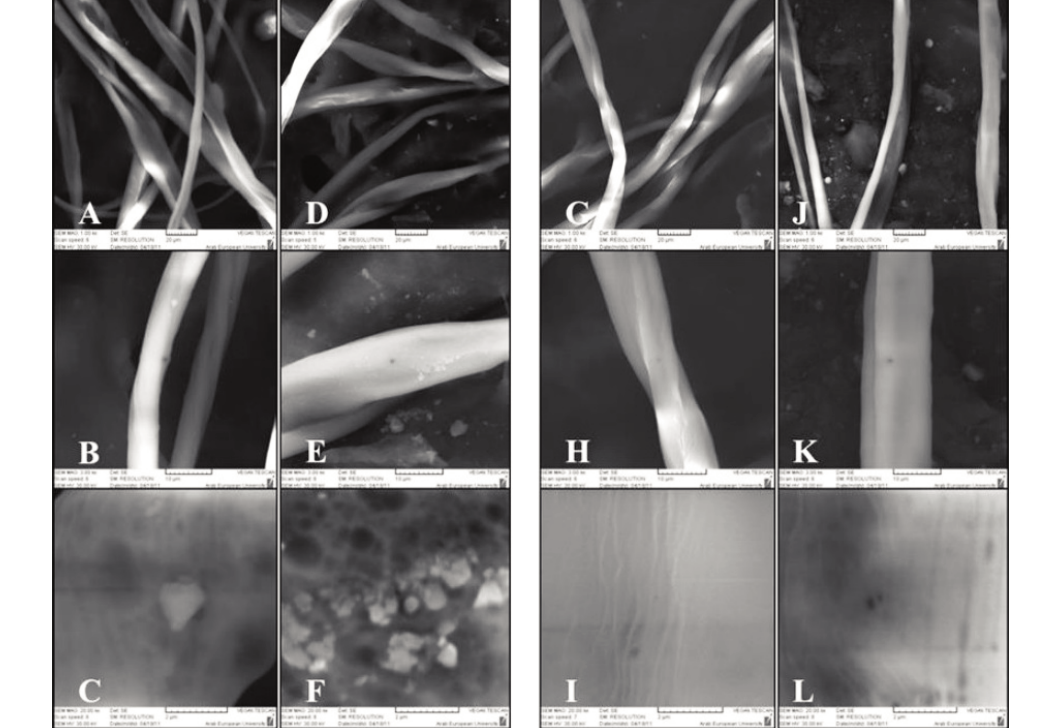
Fig. 7 - SEM images of cotton fibers. A, B and C. fibers of control ‘Aleppo 118’ under 1.00, 3.00 and 20.00 kx magnifications. D, E and F. fibers of treated ‘Aleppo 118’ under 1.00, 3.00 and 20.00 kx magnifications. G, H and I. fibers of control ‘Deir Al Zour 22’ under 1.00, 3.00 and 20.00 kx magnifications. J, K and L. fibers of treated ‘Deir Al Zour 22’ under 1.00, 3.00 and 20.00 kx